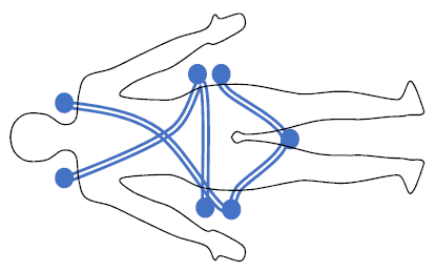
Figure 3. Diagram of the 7-point seatbelt setup on a human